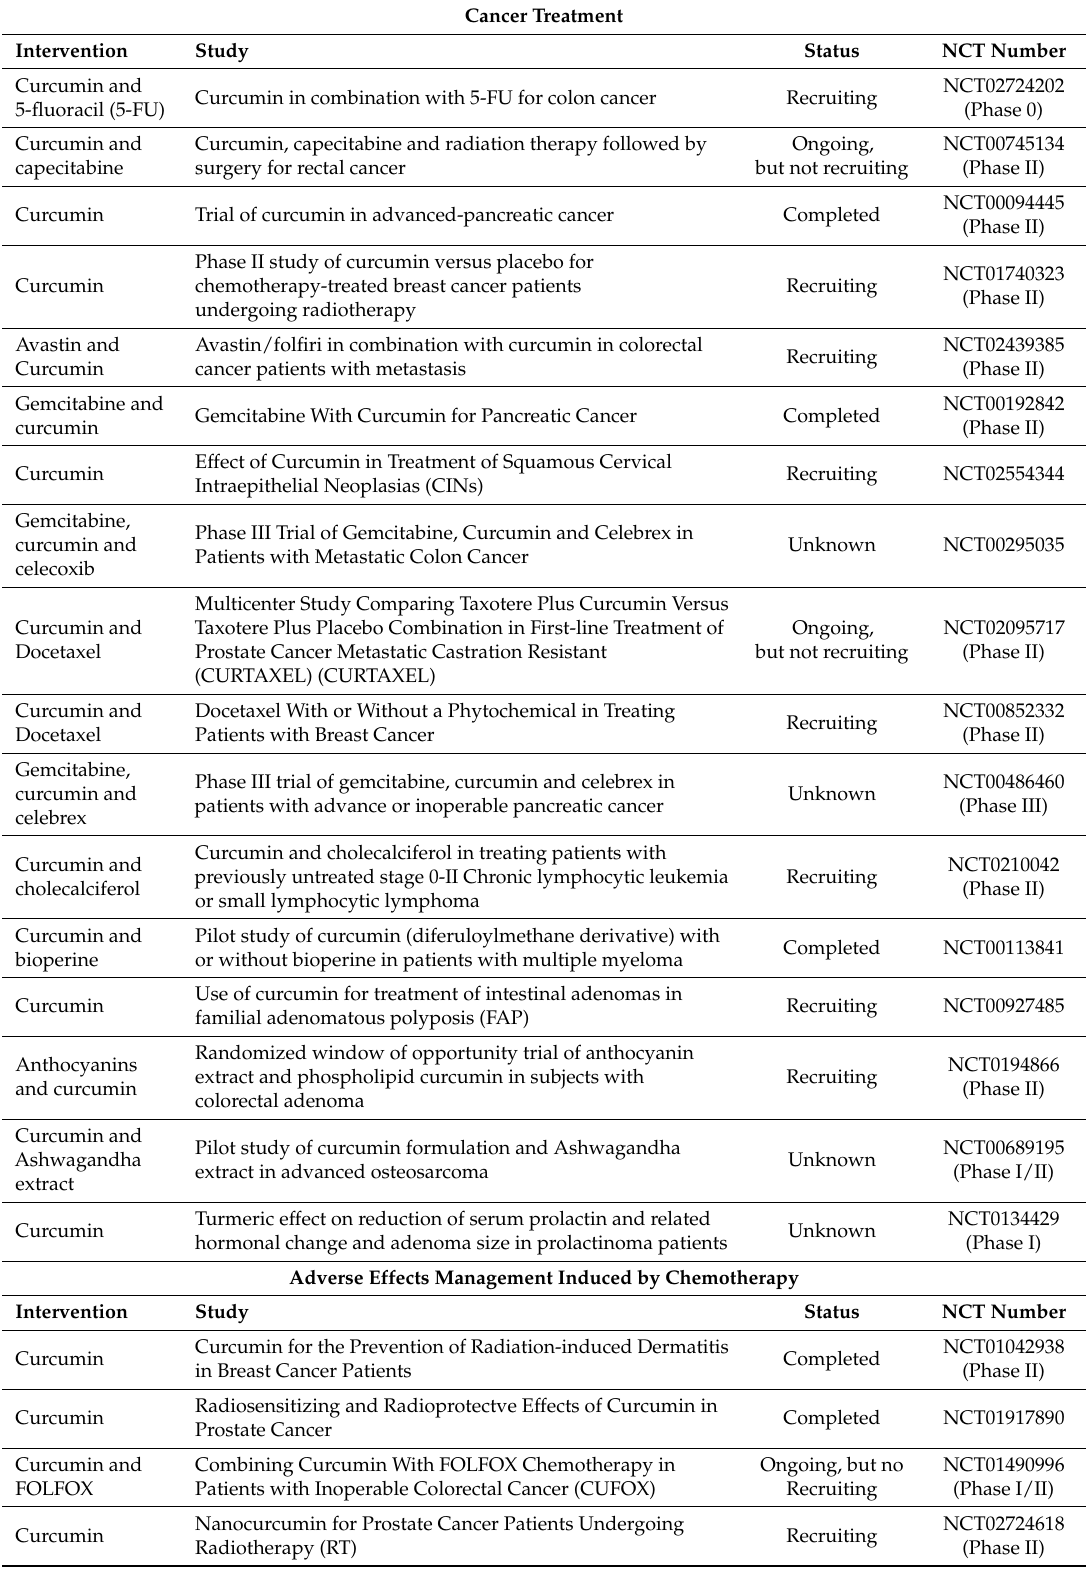
Table 7. Human studies using curcumin in